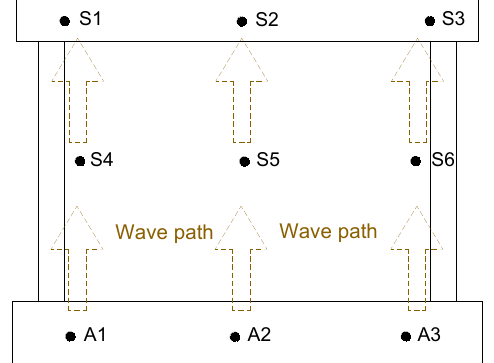
Figure 7. Locations of the actuators and sensors in the specimen and the wave path.